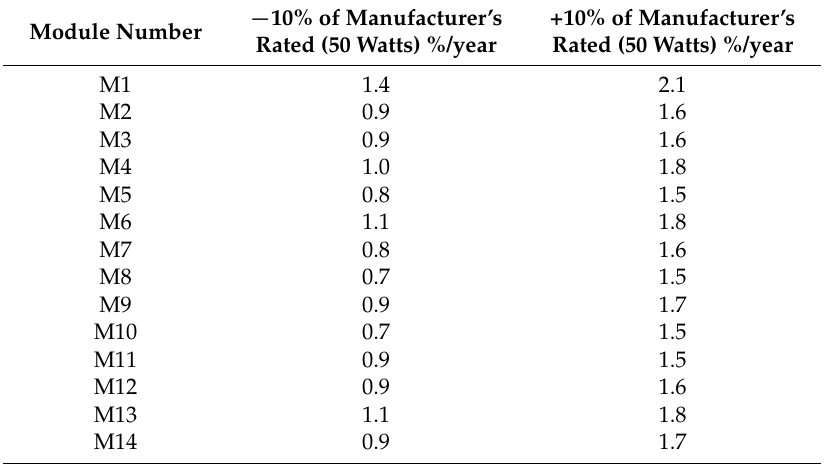
Table 5. Rate of degradation using ± 10% of manufacturer’s rated power (50 watts).